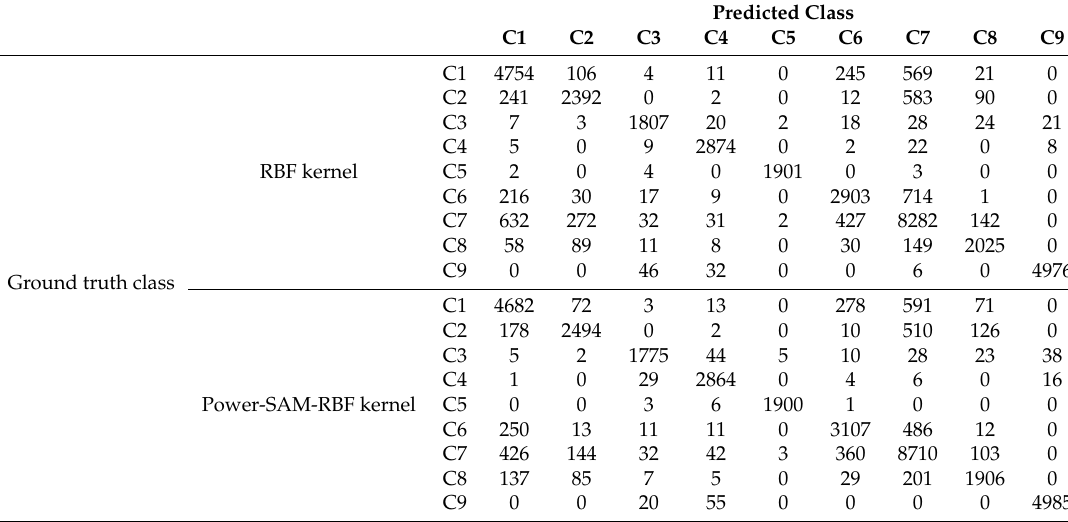
Table 7. Summation of five experimental results in the confusion matrix for the Indian Pines dataset with a proportion of training data of